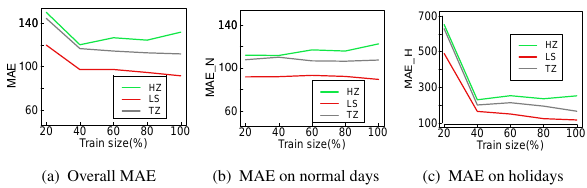
Fig. 10 MAE comparison of different training data volumes.